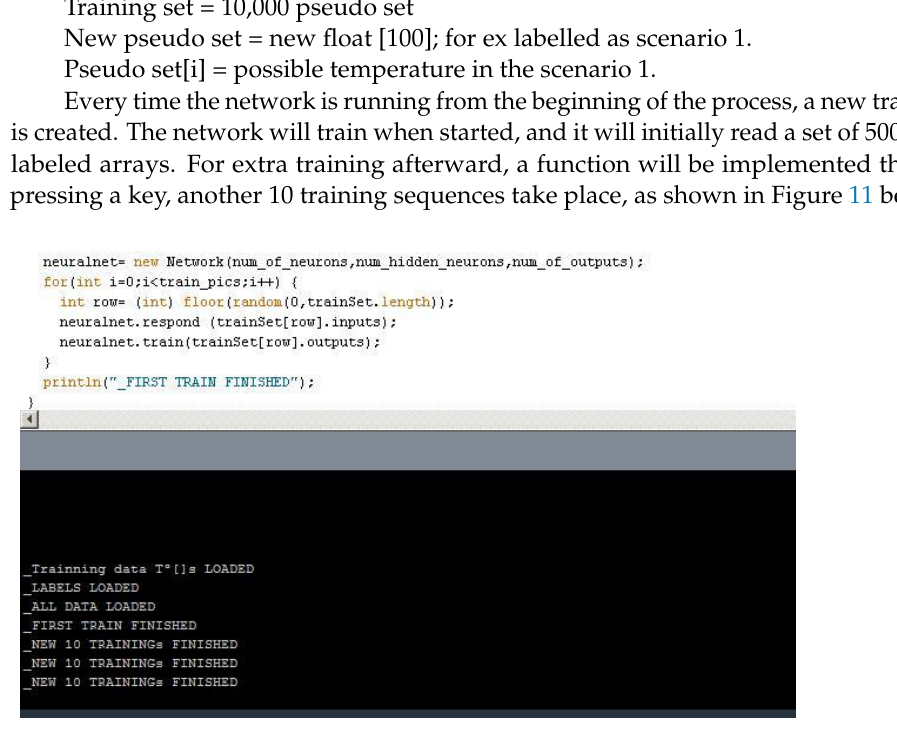
Figure 11. Training process sample code.